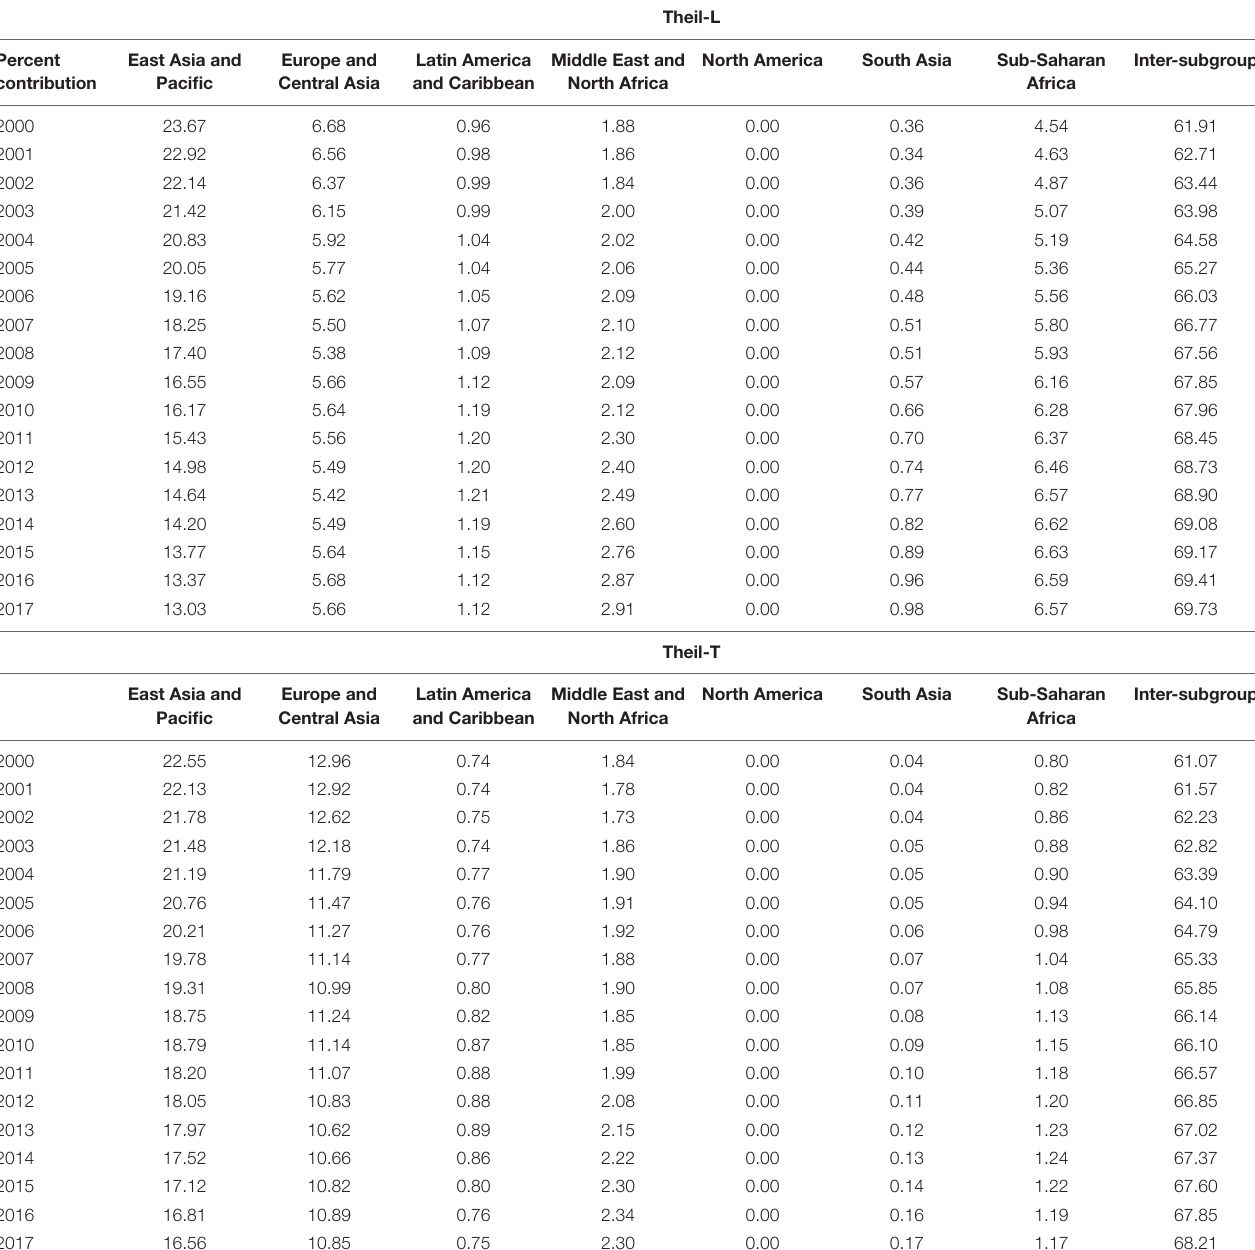
TABLE 3 | Decomposition of inequality for seven regional subgroups, 2000–2017.